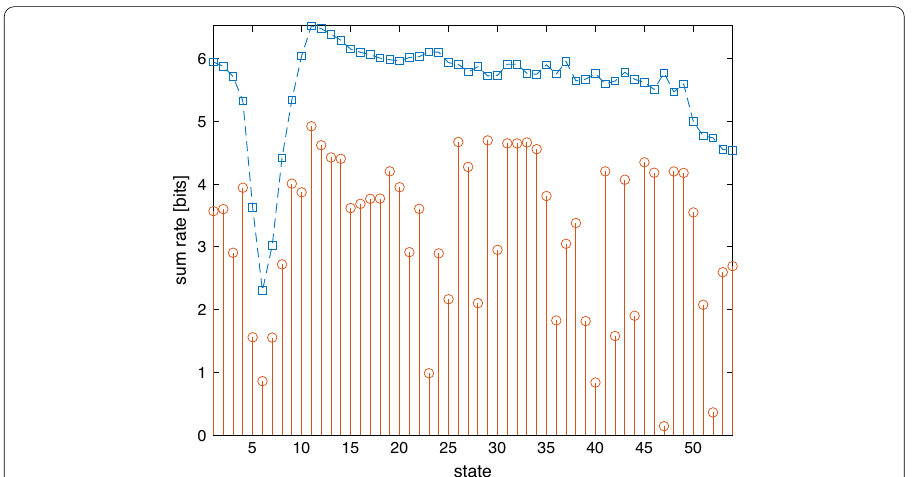
Fig. 13 Capacity for antenna states. For different liquid metal states that satisfy h 2 1 < h 2 2 < h 4 1 P (cid:31) capacity with Gaussian inputs ‘ and the achievable sum rate (via the lower bound in Proposition 1) using − − discrete PAM inputs ‘ −◦